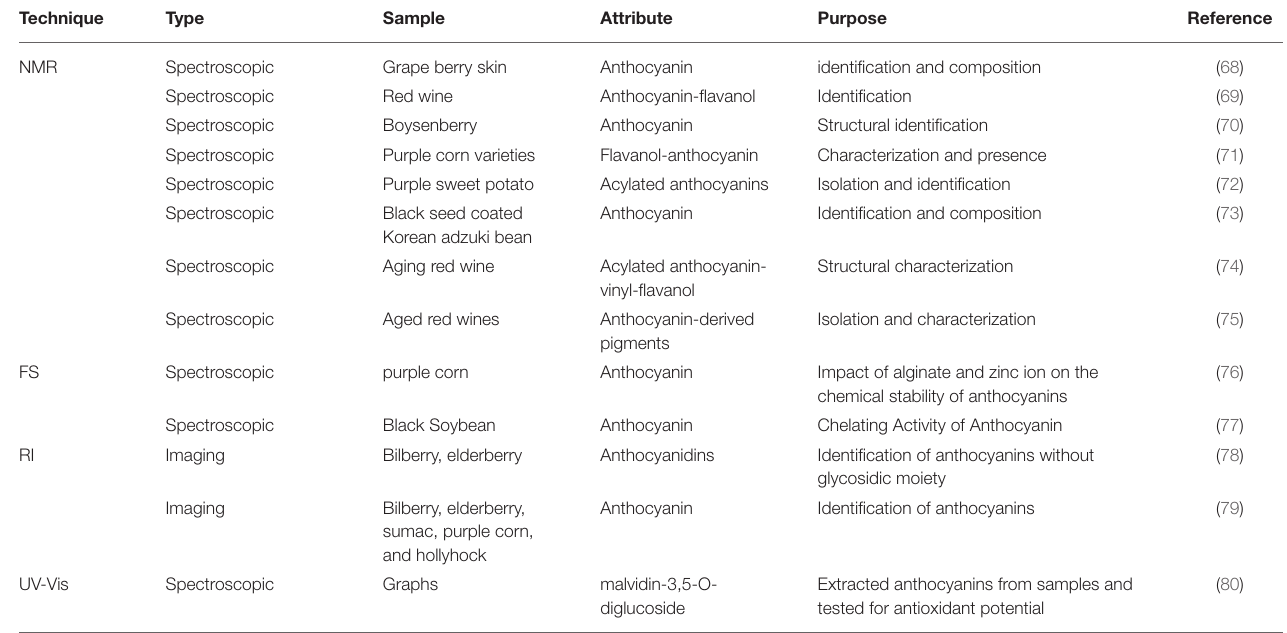
TABLE 2 | NMR, FS, RI, and UV-Vis techniques for the measurement of anthocyanin.